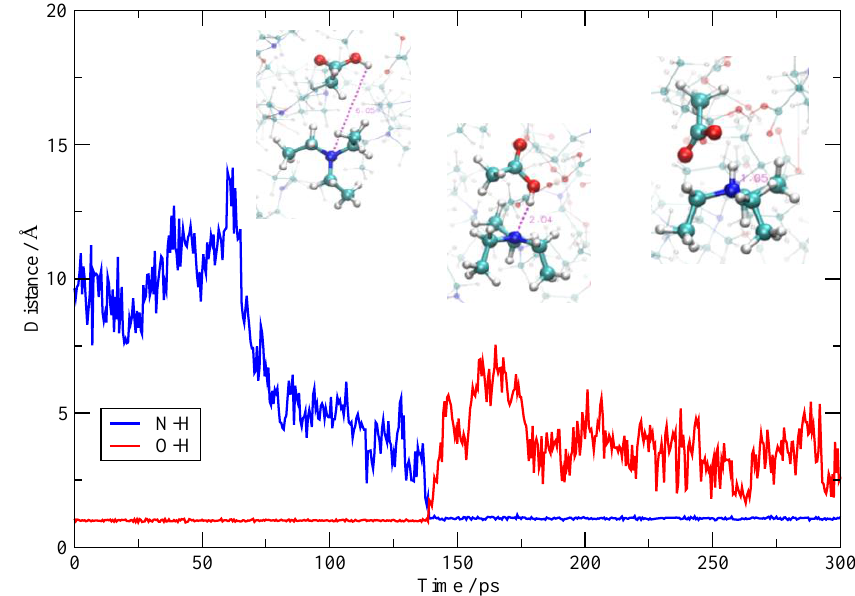
Figure 6. One of the AcOH → TEA proton transfers. The plot reports the O–H and N–H distances (red and blue, respectively). The superimposed snapshots show the geometric configurations of the involved molecules along the dynamics (around 75, 130, and 200 ps).